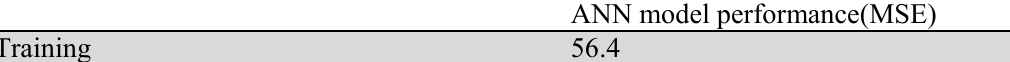
Performance analysis of MCS model (mean squared error)